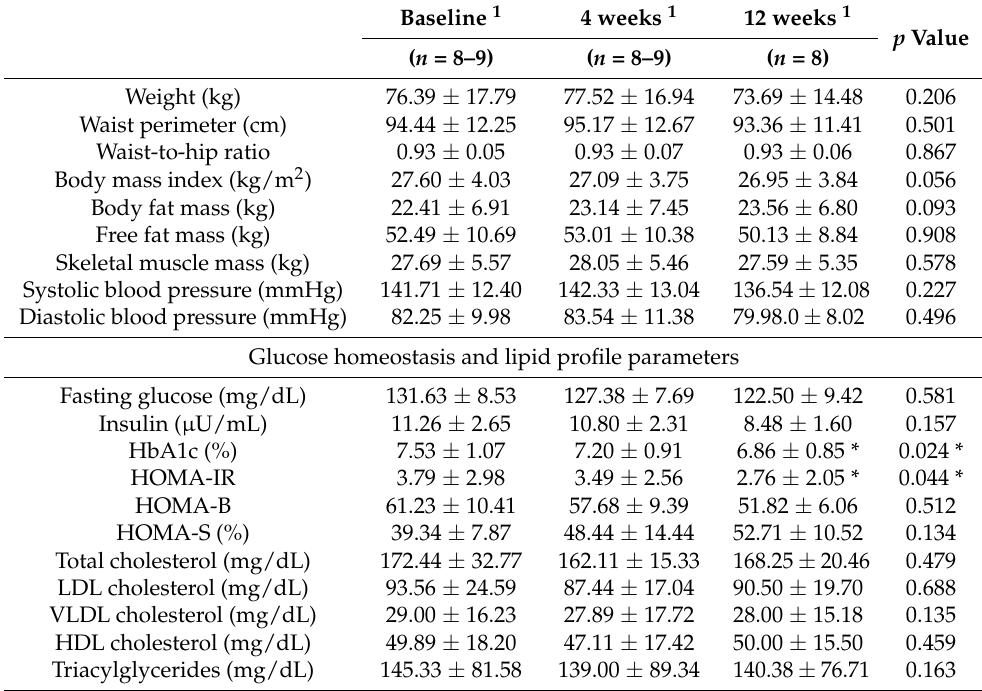
Table 3. Anthropometric, body composition, and blood pressure measurements and evaluation of biochemical parameters (glucose homeostasis and lipid